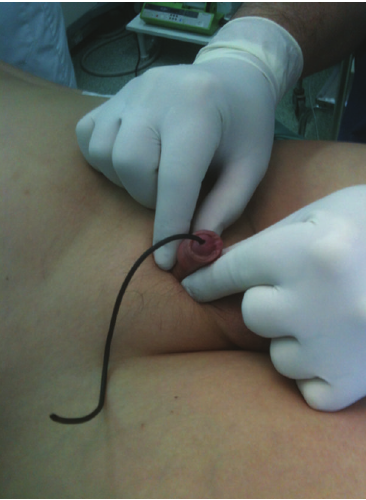
Figure 1: Clinical presentation of the inserted cable in the urethral meatus.